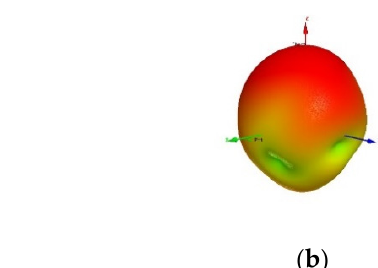
Figure 13. Realized gain with the shorting pin at ( a ) 402.5 MHz and ( b ) 2.45 GHz.